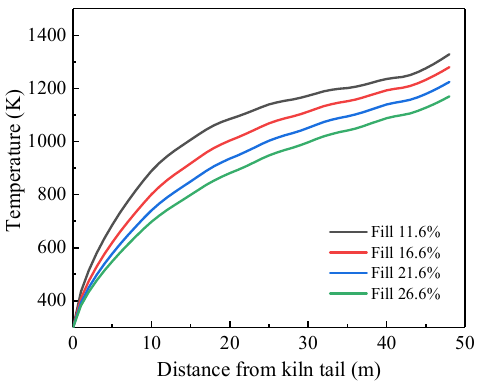
Figure 14. Average bed temperature along the axial section for different fill degrees.